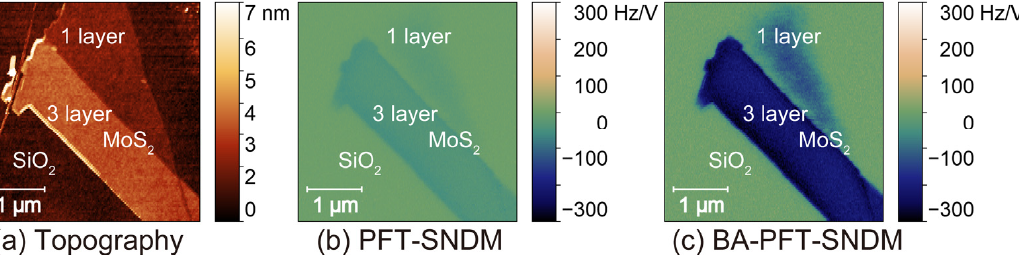
Figure 10. Topographic ( a ), PFT-SNDM ( b ), and BA-PFT-SNDM ( c ) images of few-layer natural MoS 2 mechanically exfoliated on a thermally oxidized Si substrate.